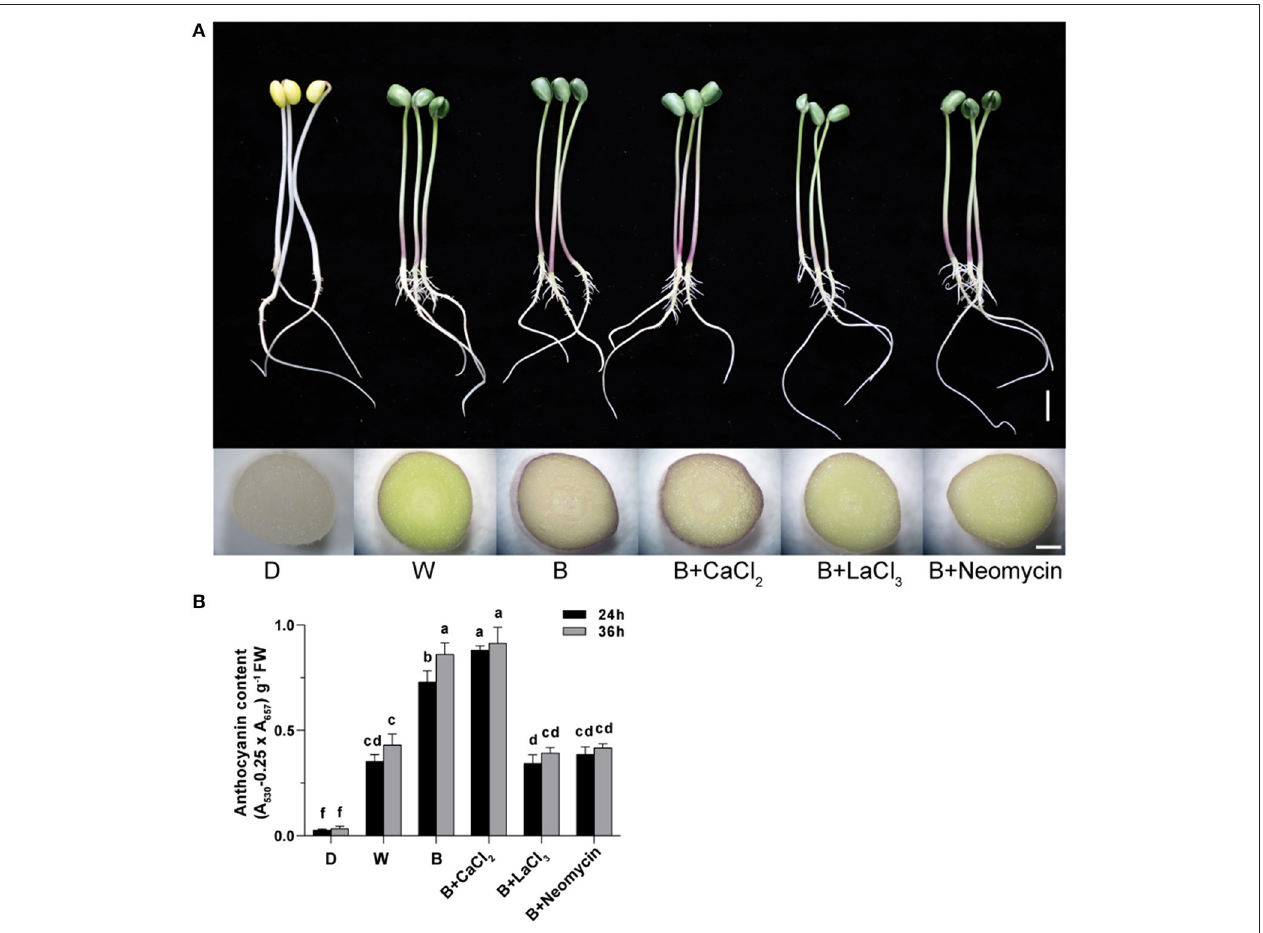
FIGURE 1 | Effects of light, CaCl 2, and Ca 2 + inhibitors on phenotype of “Dongnong 690” sprouts and total anthocyanin content in hypocotyl in different treatments. (A) Phenotype of “Dongnong 690” sprouts (up panel, bar = 1cm) and cross section of hypocotyl (down panel, bar = 0.1cm) under different conditions, 24h after sowing. (B) The total content anthocyanin in hypocotyls, 24 and 36h after sowing. Values are the mean ± SE of triplicate ( n = 3). The different letters represent significant differences among various treatments ( p < 0.05). The different treatments were as follows: (1) D: cultivated with purified water without light; (2) W: